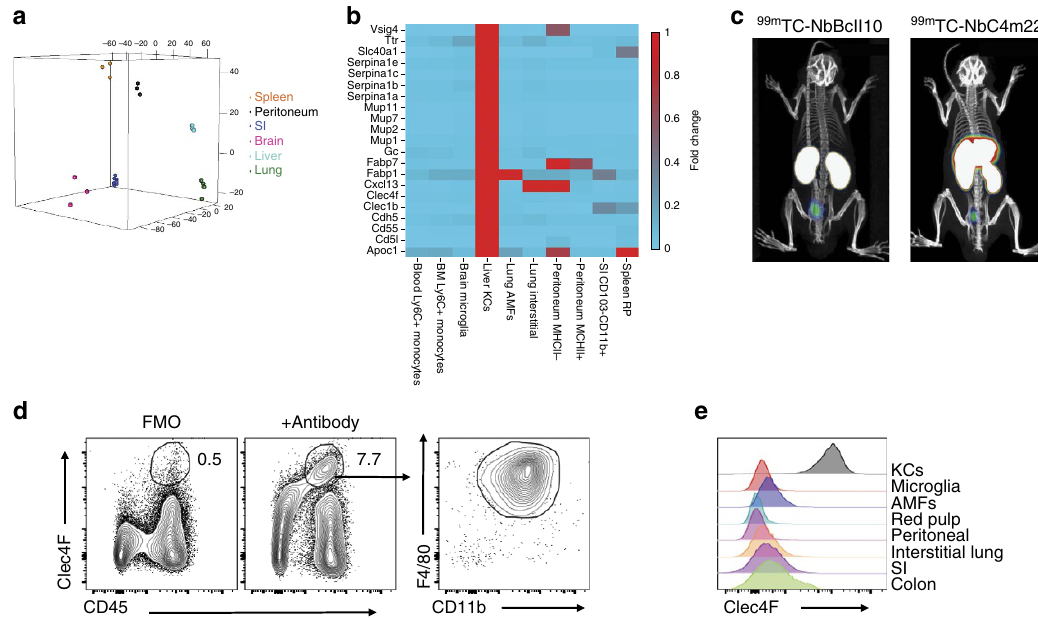
Figure 1 | Identification of a KC-specific gene. ( a ) Principle component analysis of transcriptional profiles of KCs compared with other tissue-resident m f s. ( b ) Heatmap of mean fold change in core KC genes. Expression level in KCs was set at one. ( c ) SPECT/ m CT images 1h post injection with control (NbBcII10) or anti-Clec4f (NbC4m22) 99m Technetium-labelled nanobodies. Representative of two experiments with n ¼ 6. ( d ) Clec4F, CD45, F4/80 and CD11b expression in liver cells. Representative of 5 experiments. ( e ) Clec4F expression by m f populations. AMFs, alveolar m f s; red pulp, splenic red pulp m f s; SI, small intestinal M f s; Representative of two experiments. NATURE COMMUNICATIONS|7:10321|DOI: